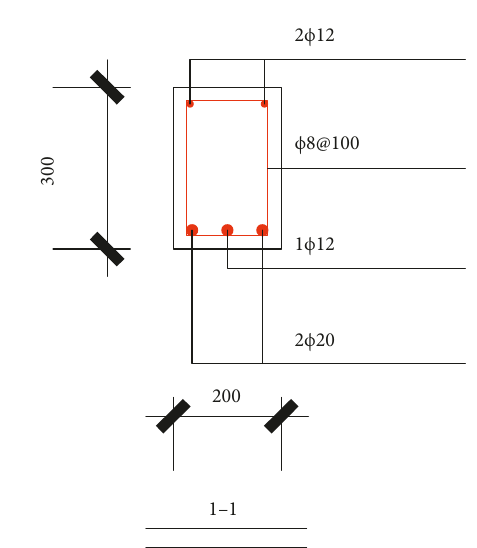
Figure 6: The reinforcement of beam section.